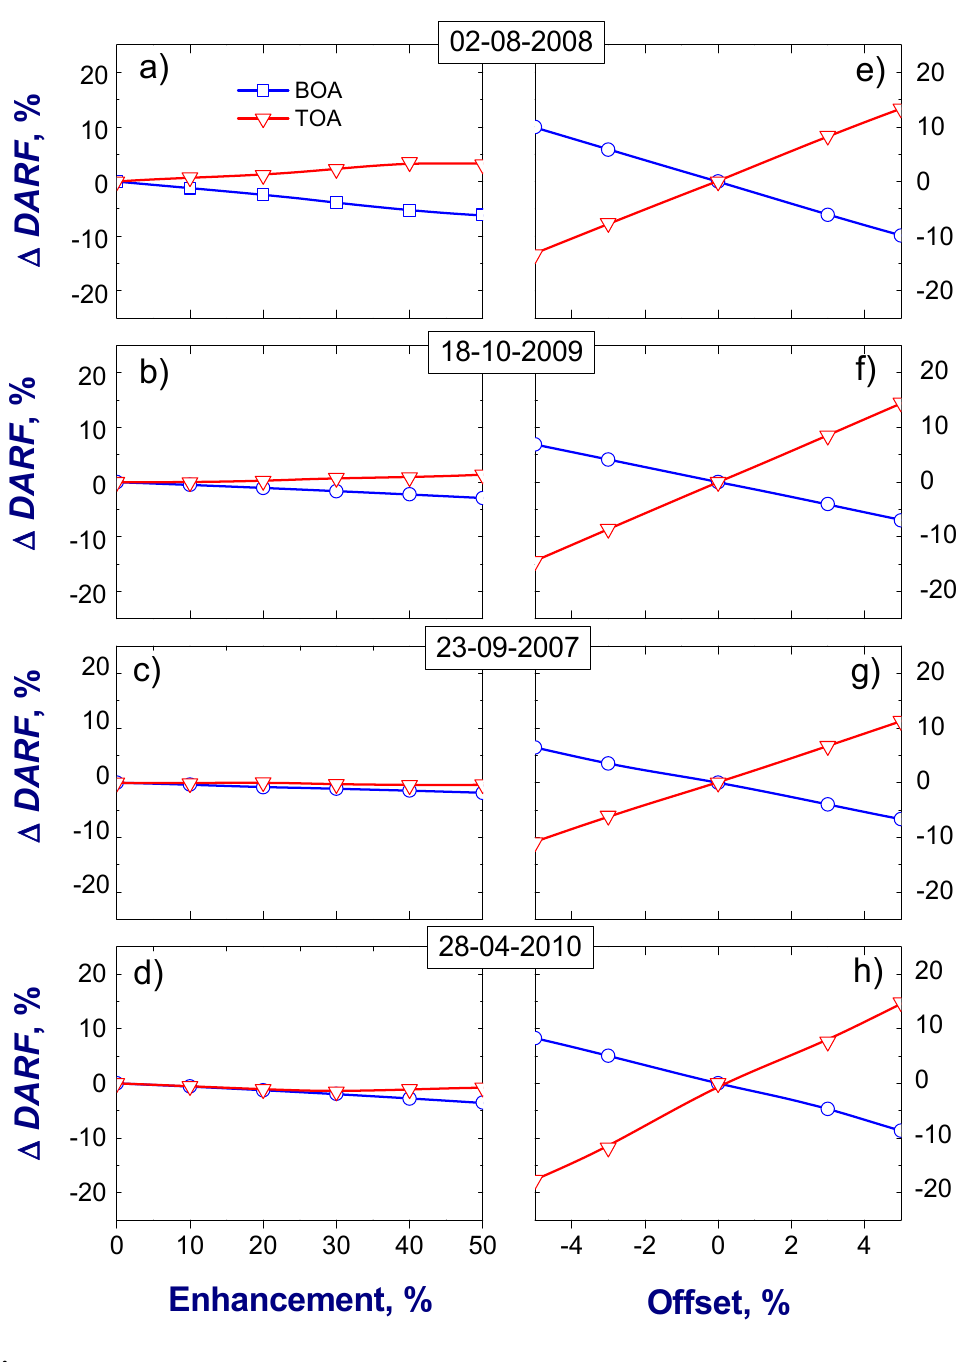
Figure 11. The same as Figure 5, except that these differences correspond to the direct aerosol radiative forcing (DARF) at the top of atmosphere (TOA, red) and the bottom of atmosphere (BOA,